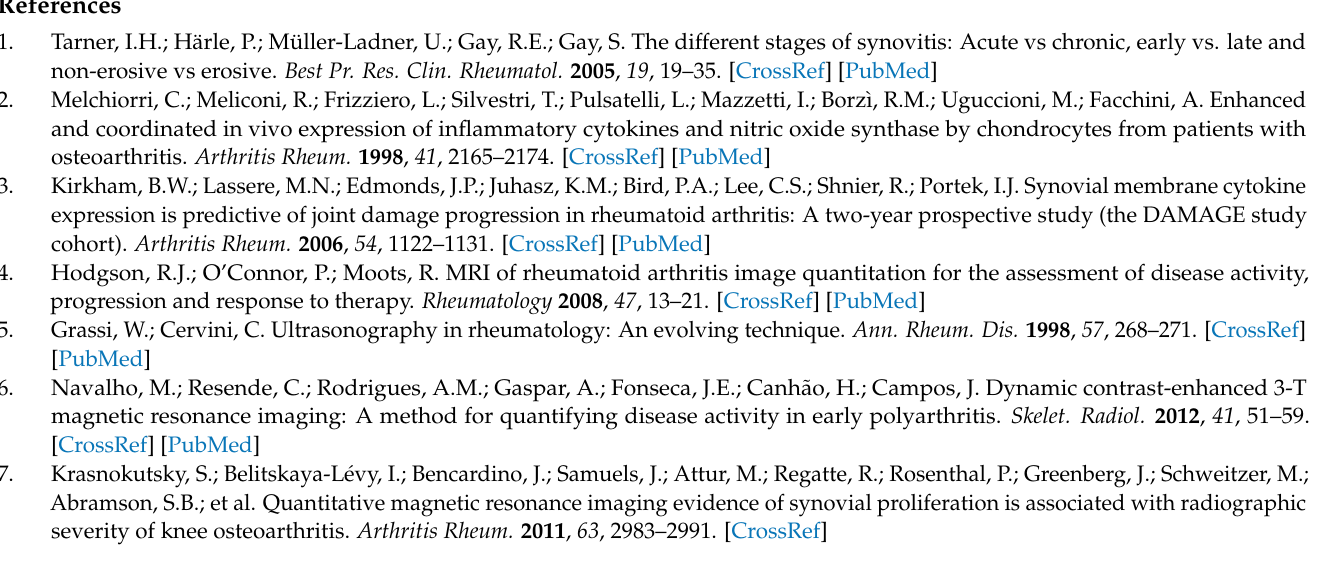
Table S2: Correlation between the values of DTI & DCE–MRI indices with various infiltrating immune cells in the synovium of different group of arthritis patients ( n = 80). Results are expressed as R values.; Table S3: Correlation between the values of DTI and DCE –MRI indices with various cytokines in the synovial fluid of different group of arthritis patients ( n = 80). Results are expressed as R values; Table S4: Multivariate linear regression for predicting Total cells infiltrating the synovium as dependent variable and DTI and DCE metrics as independent variables; Table S5: Multivariate linear regression for predicting CD34 as dependent variable and DTI and DCE metrics as independent